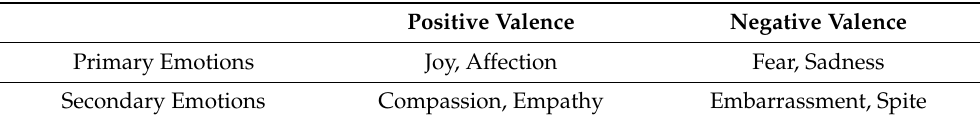
Table 1. Categorisation of individual emotions included within. Positive Valence Negative Valence Primary Emotions Joy, Affection Fear, Sadness Secondary Emotions Compassion,